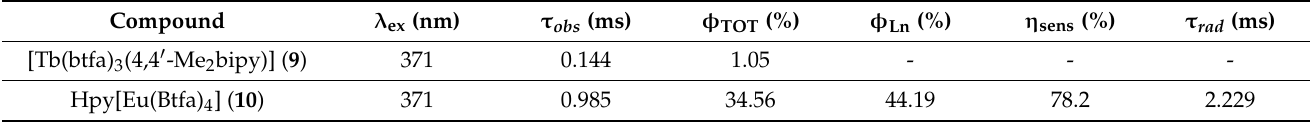
Table 2. Characteristic photoluminescent data for compounds 9 and 10